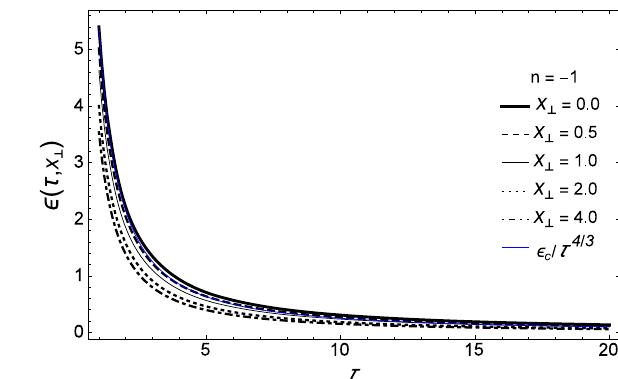
Fig. 7 (cid:5)(τ, x ⊥ ) as a function of τ for several values of x ⊥